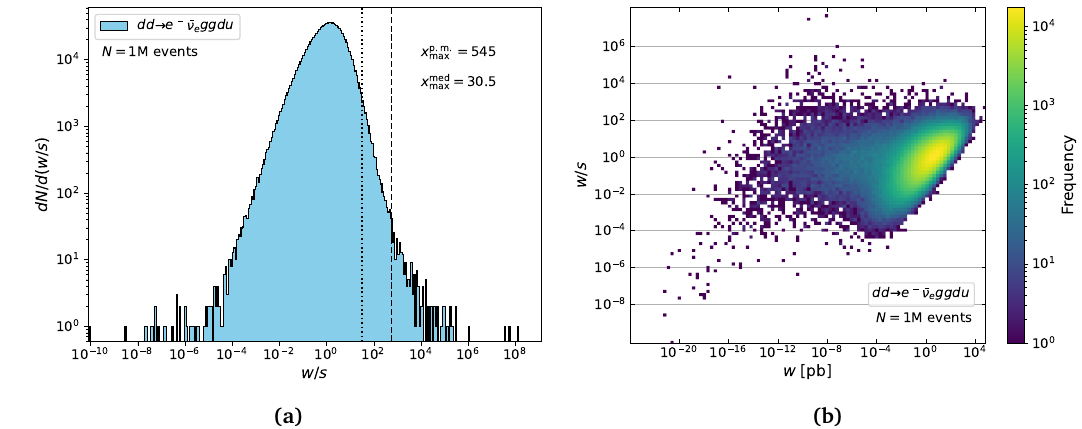
Figure 6: Distribution of weights using 1M test points generated with S HERPA for (cid:112) g gdu in proton–proton collisions at s = 13 TeV. (a) One- the process dd → e − ¯ ν e dimensional histogram of the ratio x = w . The two vertical lines indicate the values of s the reduced weight maxima x p.m. (dashed) and x med (dotted). (b) Two-dimensional max max histogram showing the relationship between the ratio x = w and the true event s weight w